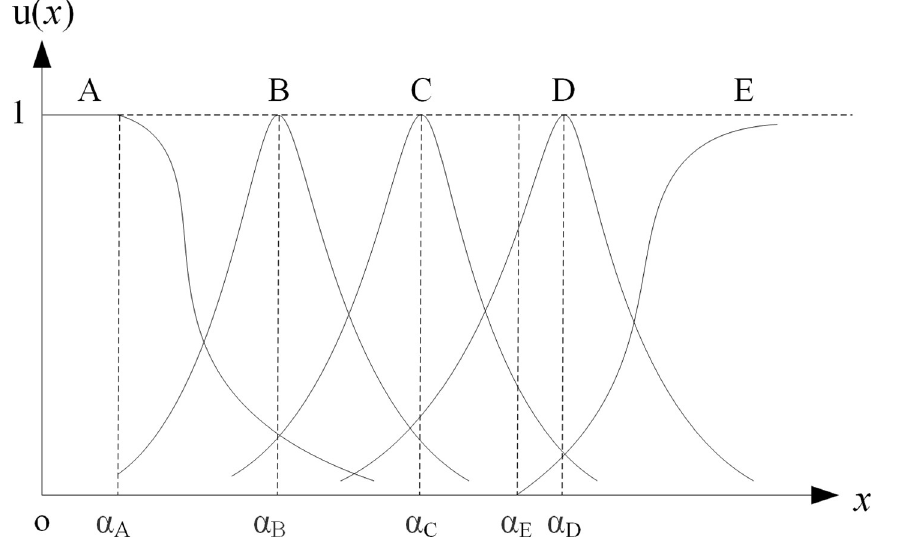
Fig 1. Membership vector of final-level hoping-small